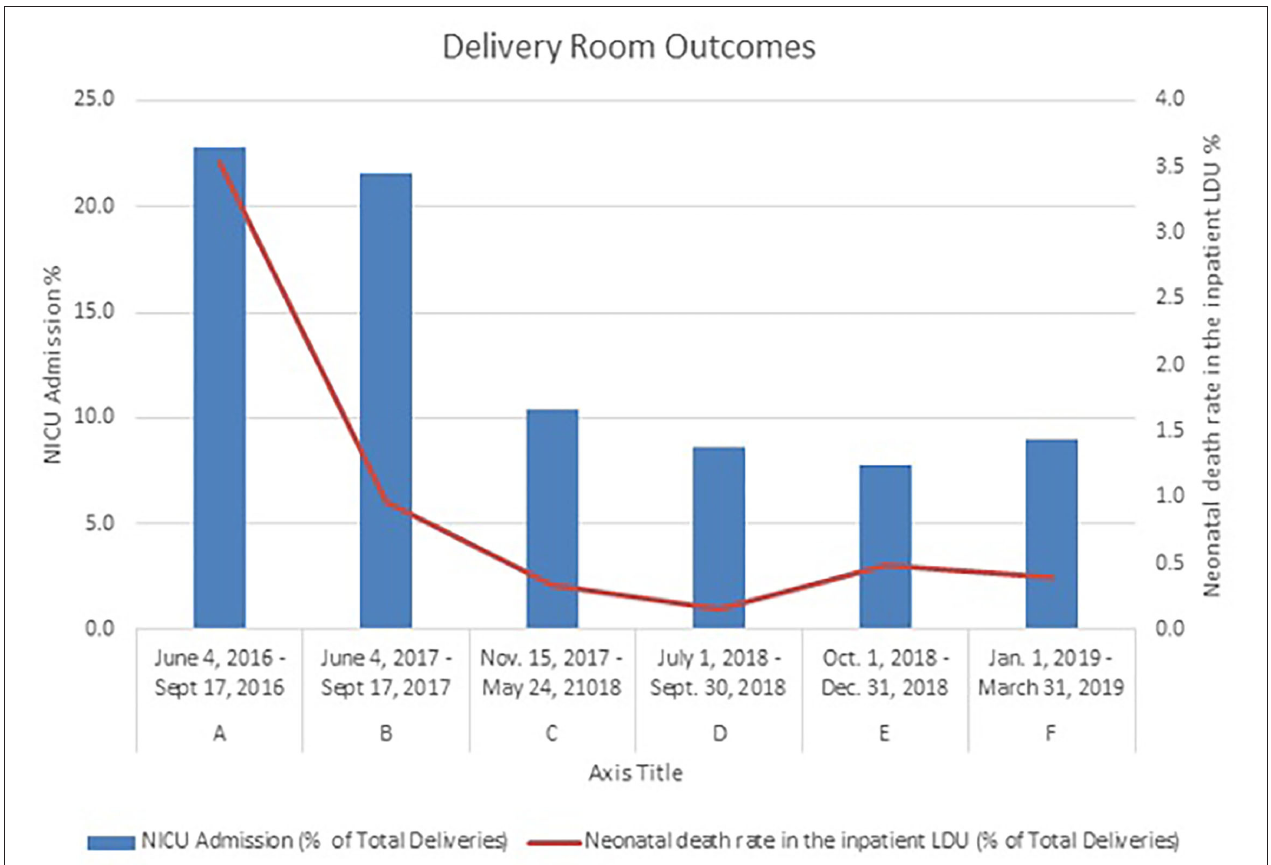
FIGURE 3 | Neonatal death rate in the inpatient LDU and NICU admission rate before and after the implementation of the NALS service. Both fell significantly between groups A and C (p < 0.001) and were sustained further between groups D and F.